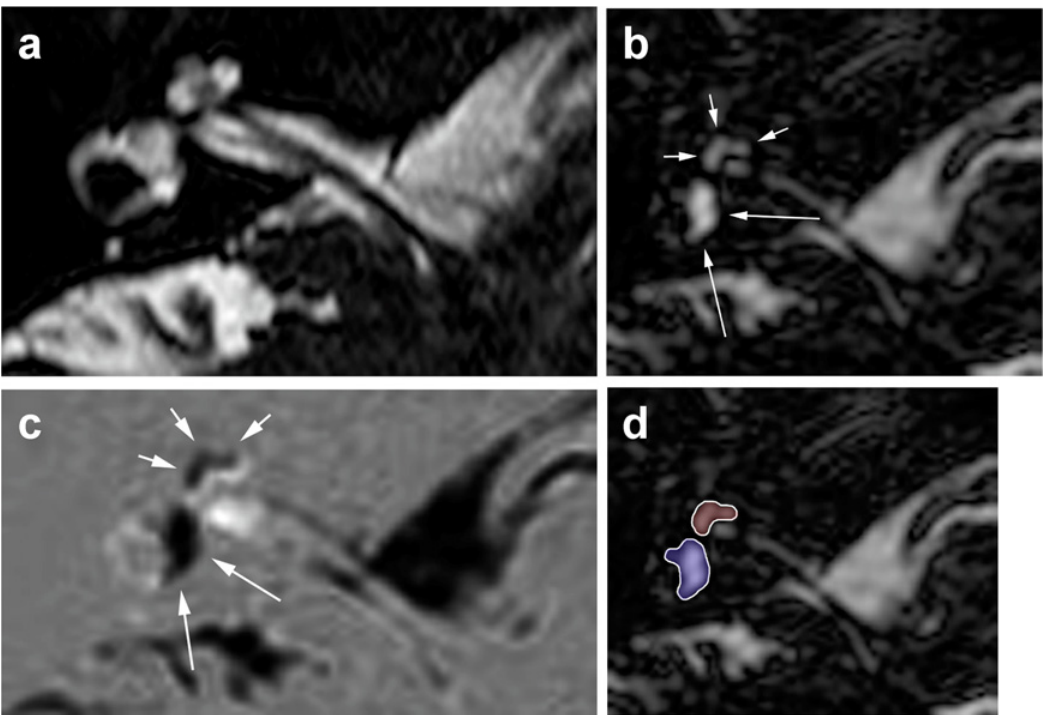
Fig 1. Images of a 57 year old woman with Meni è re ’ s disease, obtained 4h after i.v.-administration of a single-dose Gd-DO3A-butrol. (a) T2DRIVE- cisternography reveals the anatomy of the total lymphatic fluid of the right inner ear. (b) hT2w-FLAIR PEI with an inversion time of 2050 ms displays the endolymphatic fluid. (c) The HYDROPS (HYbriD of Reversed image Of Positive endolymph signal and native image of positive perilymph Signal) image, gained by subtraction of PEI from PPI, reveals the enlarged endolymphatic space as black area. Diagnosis after semi-quantitative analysis was a significant (II°) endolymphatic hydrops of the vestibule (long arrows) and the cochlea (short arrows). Volumetric assessment was performed by dedicated slice-by-slice- segmentation of the endolymphatic space in PEI (d) and the total labyrinth fluid space in T2DRIVE-cisternography. This patient showed an endolymph/total labyrinthine fluid-ratio of 50.51% (cochlea) and 54.3%